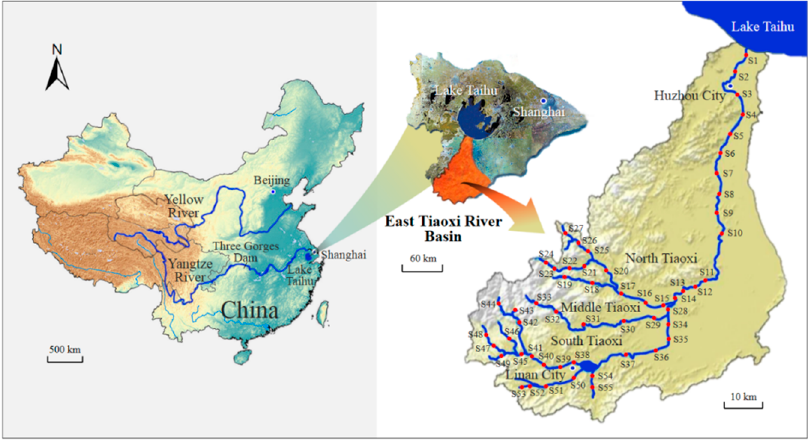
Figure 1. Study area and sampling sites.